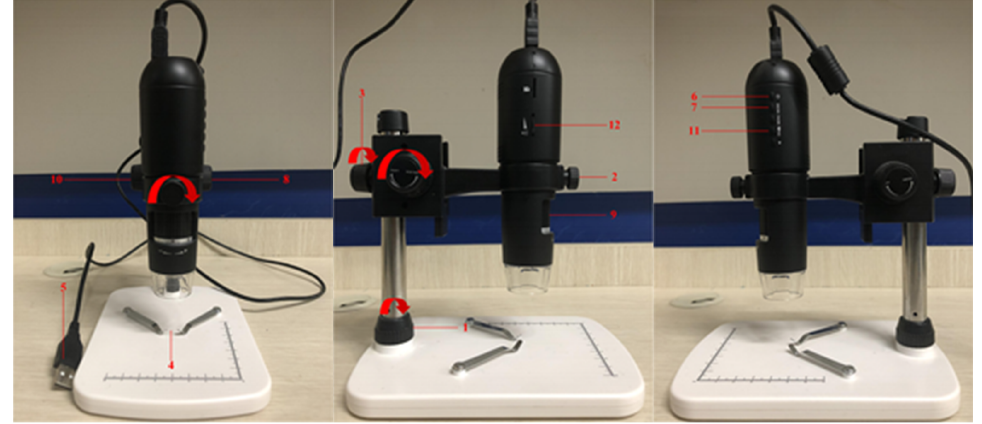
Figure 9. A 1080P HDMI digital microscope.